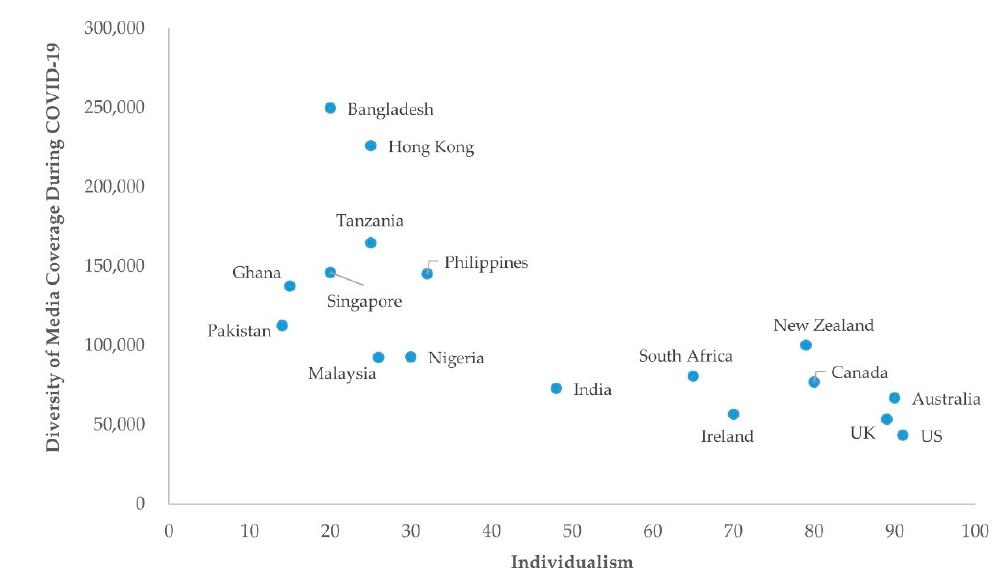
Figure 2. Scatterplot for diversity of media coverage during COVID-19 and individualism scores for 17 countries.